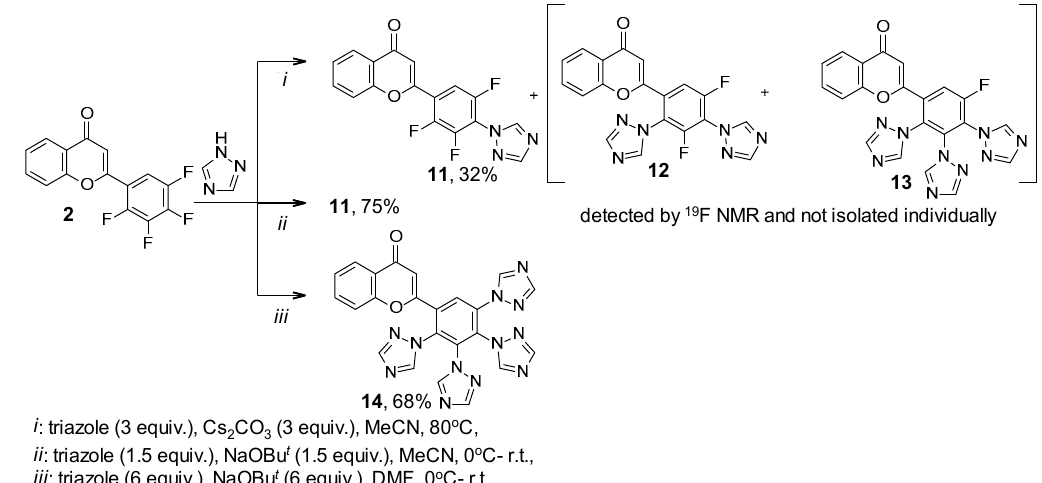
Scheme 3. Reaction of 2-(2,3,4,5-tetrafluorophenyl)-4 H -chromen-4-one 2 with 1 H -1,2,4-triazole.